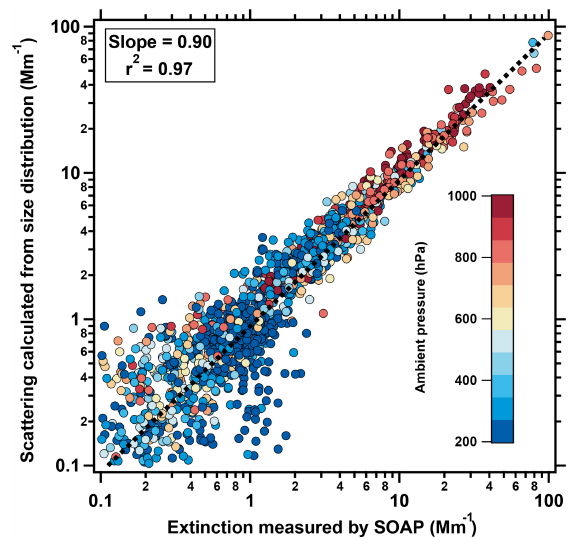
Figure 12. Dry aerosol scattering at 532nm calculated using Mie theory from the particle size distributions measured by the NMASS, UHSAS, and LAS instruments as a function of the dry aerosol ex- tinction at 532nm measured directly by the SOAP instrument. Data are 60s averages from the entire ATom-4 campaign. Line and slope are from a two-sided linear least-squares fit forced through zero in- tercept. Value of r 2 is from a one-sided linear least-squares regres-